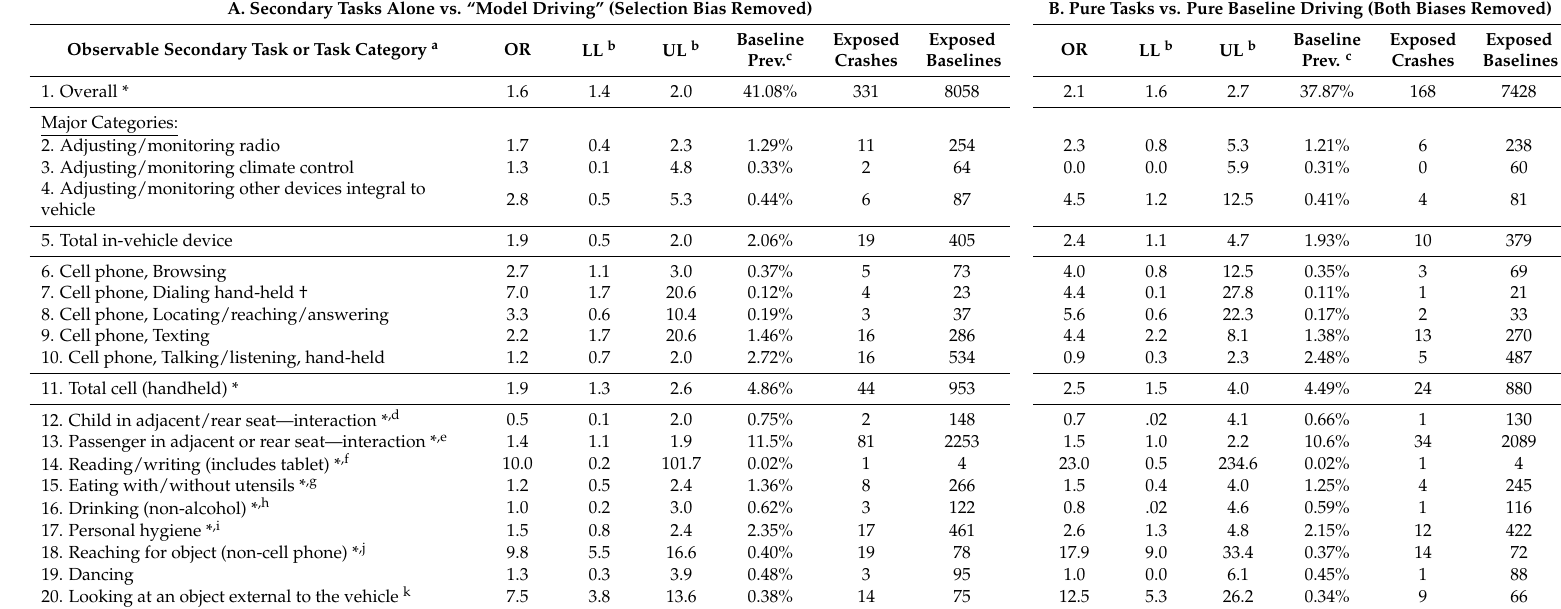
Table A3. (A) OR estimates after removing selection bias. (B) OR estimates after removing selection and confounding bias. A. Secondary Tasks Alone vs. “Model Driving” (Selection Bias